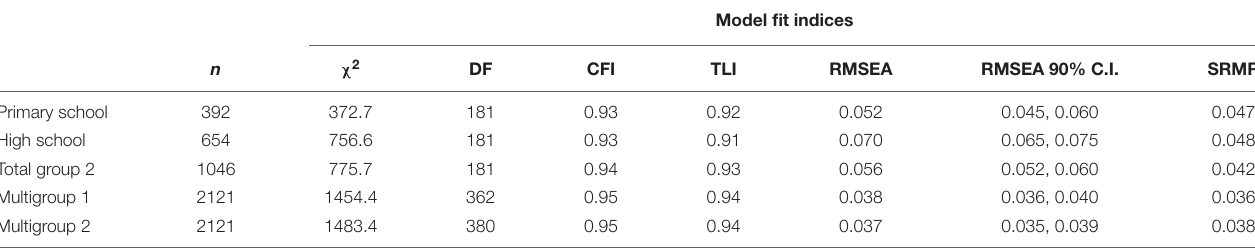
TABLE 4 | Model fit indices for the 21-item DASS-Y in the cross-validation sample ( N = 1046), and for multigroup comparisons between the calibration and cross-validation samples.